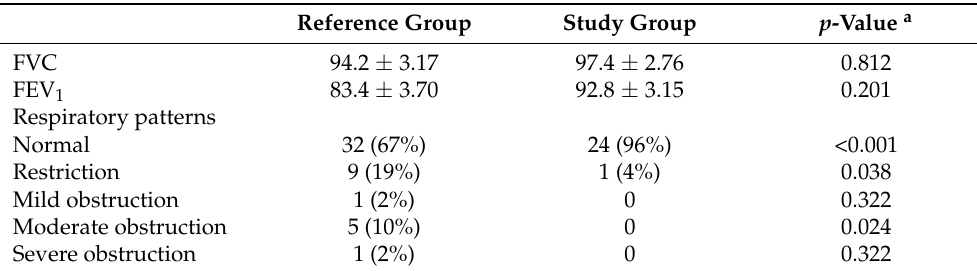
Table 3. Description of the spirometry tests performed in the studied populations (mean ± standard error—for continuous variables or % for categorical